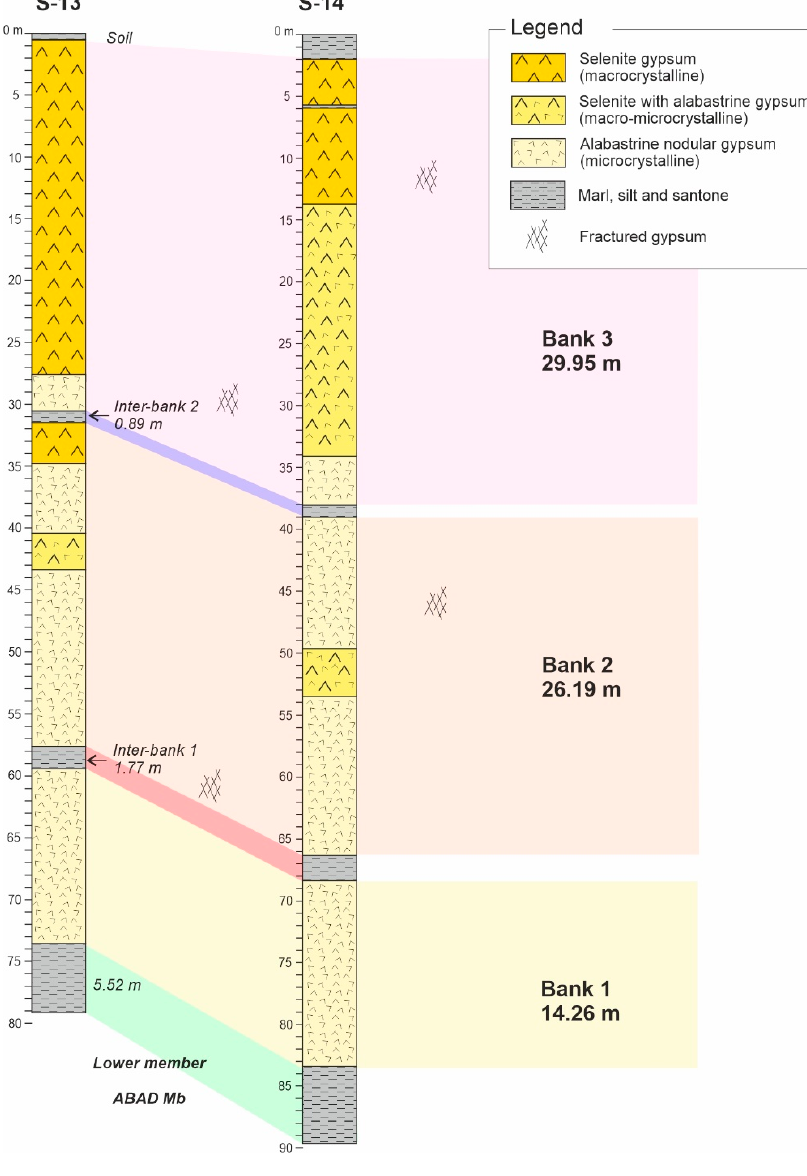
Figure 9. Lithology of the borehole cores corresponding to S-13 and S-14.